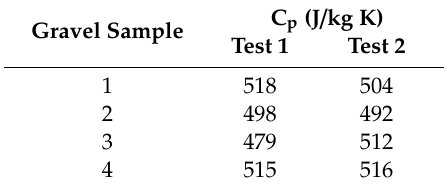
Table 1. Experimental values of specific heat capacity of gravel at 185 K.